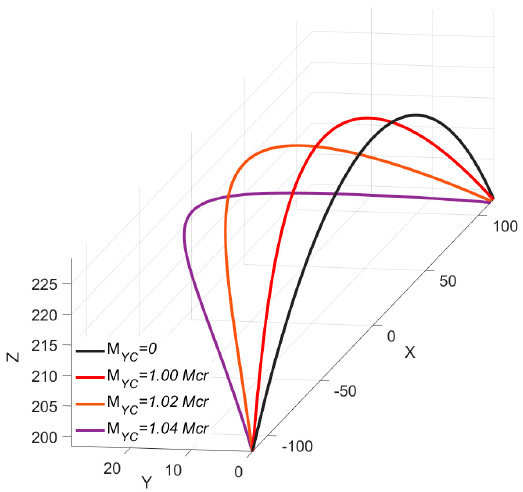
Figure 18. Load versus displacement curves for the curved beam subject to negative moment.